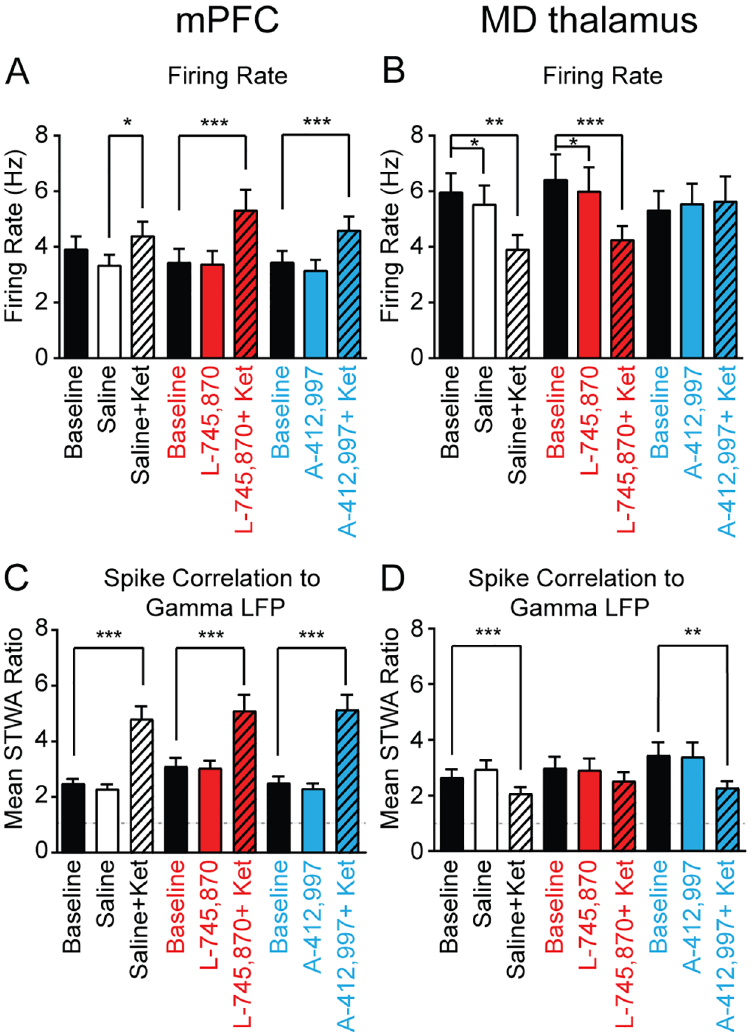
Fig 5. Effects of dopamine D4R agonist and antagonist on ketamine-induced changes in spiking activity. A-B, Average firing rates of putative mPFC pyramidal neurons( A ) and MD thalamusneurons( B ) at baseline(black), 15 minutes after the pretreatment injection(solid color), and 15 minutes after the subsequent additional administration of 10 mg/kg ketamine(striped). Bars in white, in red or in blue correspond to pretreatments with either saline,antagonist5 mg/kg L-745,870 s.c., or agonist 3 mg/kg A-412997s.c., respectively(saline: mPFC: n = 45 neurons,MD thalamus: n = 37 neurons; L-745,870:mPFC: n = 30 neurons, MD thalamus: n = 31 neurons; A-412997:mPFC: n = 38 neurons, MD thalamus: n = 31 neurons). C-D, Bar graphs show spike-gamma LFP correlations (filtered from 40–70 Hz) for mPFC pyramidal neurons ( C ) and MD thalamusneurons( D ). There were no significantdifferences betweenpretreatment groups in the effect of ketamineon firing rates or spike-LFP correlations( p > 0.05, one-wayANOVAs). All data collected from treadmill walkingepochs. Values are reportedas mean ± SEM; neuronsfrom 6 rats. * : p < 0.05, ** : p < 0.01, *** : p < 0.001, pairedbootstrap tests comparebaselinewalk and the drug treatments.